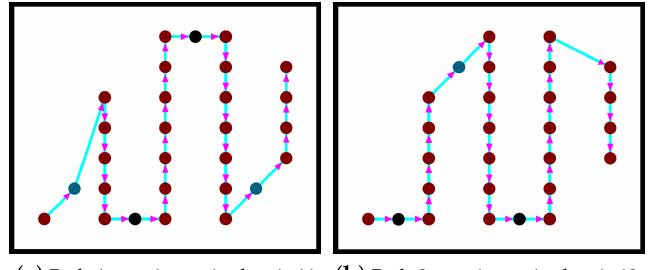
Figure 11. Two examples of generated